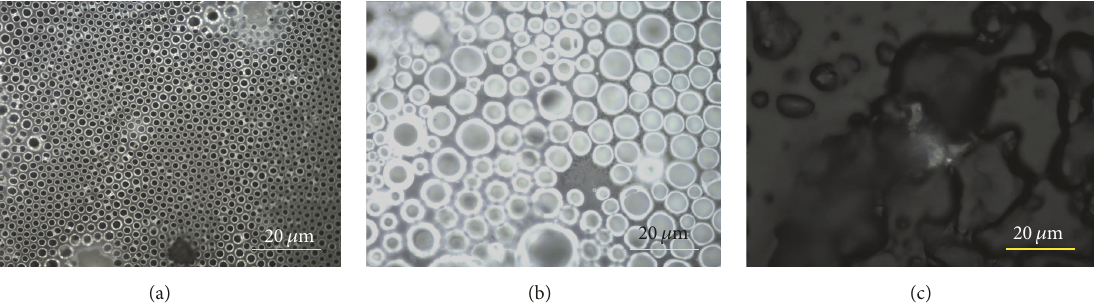
Figure 2: Influence of the nanoparticle (37% SiOH) concentration on the final porous structures obtained from the PS solution (30mg/mL). (a) 1mg/mL, (b) 2 mg/mL, and (c) 5